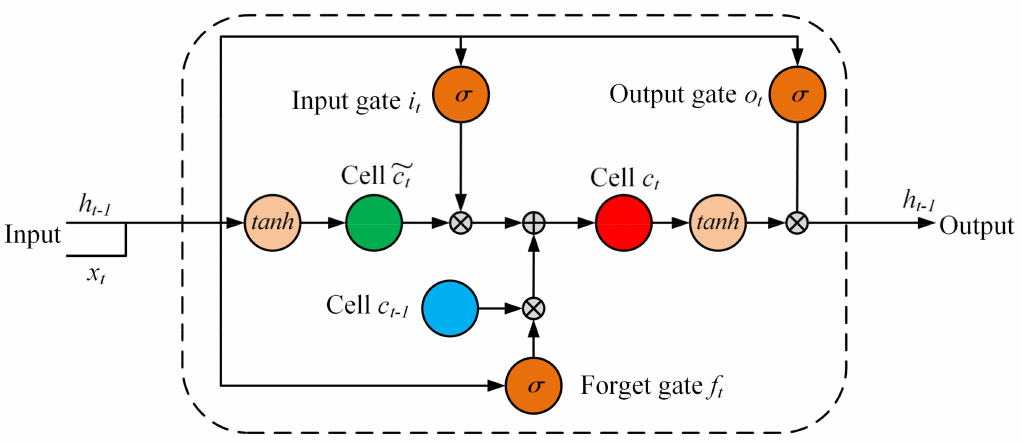
Figure 6. Structure of an LSTM